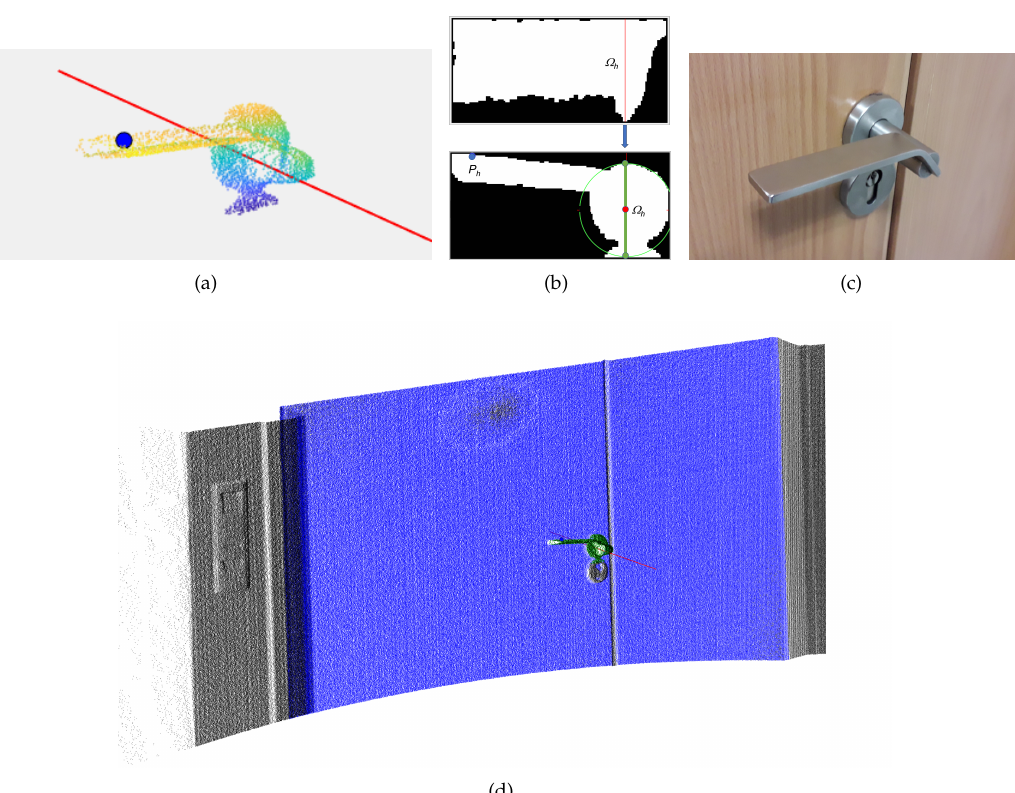
Figure 7. ( a ) Points corresponding to the door handle ( S h ). The handle rotation axis and the contact point are superimposed onto S h . ( b ) (Top) Top projection of S h and handle rotation axis in red. (Bottom) Frontal projection of S h and rotation axis (red dot). ( c ) Picture of the door handle. ( d ) Fully segmented point